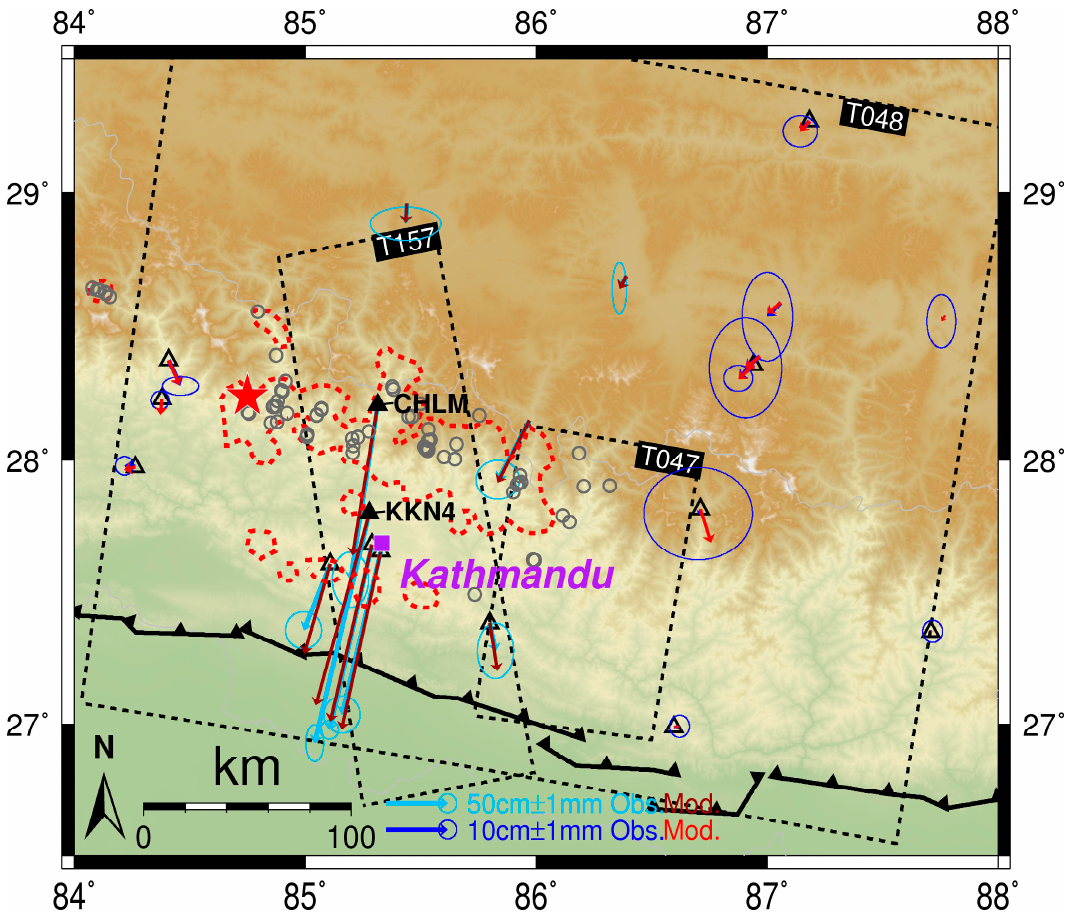
Figure 1. Data coverage and tectonic setting of the Gorkha earthquake. Blue and red vectors represent observed and ESISTEM-derived displacements, respectively. Red dashed lines outline the zones with significant landslides [2], and grey circles show distribution of landslide [11]. Thick black lines represent the Main Frontal Thrust (MFT) [12,13]. The red star represents the epicenter of the earthquake, and the purple square represents the city of Kathmandu. Filled triangles represent GPS stations CHLM and KKN4; all triangles are GPS validation stations.